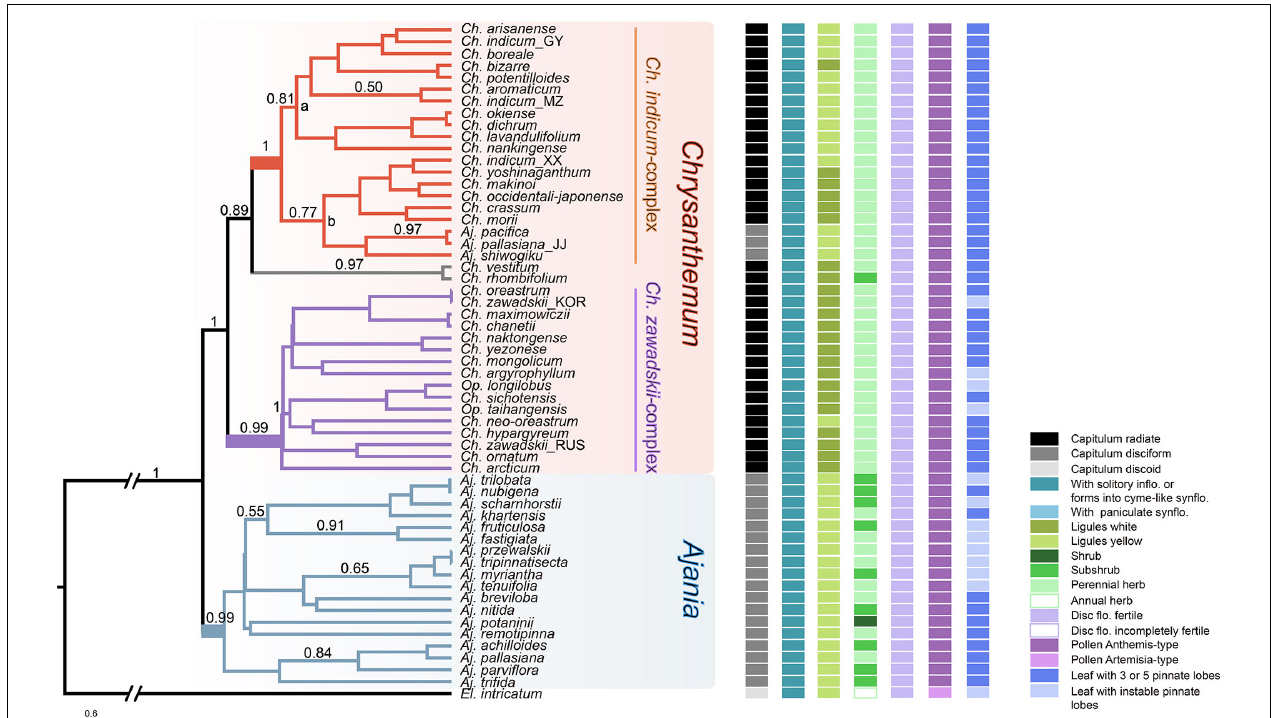
FIGURE 2 | Coalescent tree of the Chrysanthemum -group inferred from eight nuclear gene sequences. Bayesian posterior probabilities higher than 0.5 are indicated on branches. States of important morphological characters (represented by small squares in different colors) are mapped at the right side of terminal nodes. In this tree, two subclades, Ch. indicum -complex and Ch. zawadskii -complex, can be recognized within Chrysanthemum . Naming of the two Chrysanthemum subclades follows Liu et al. (2012b).